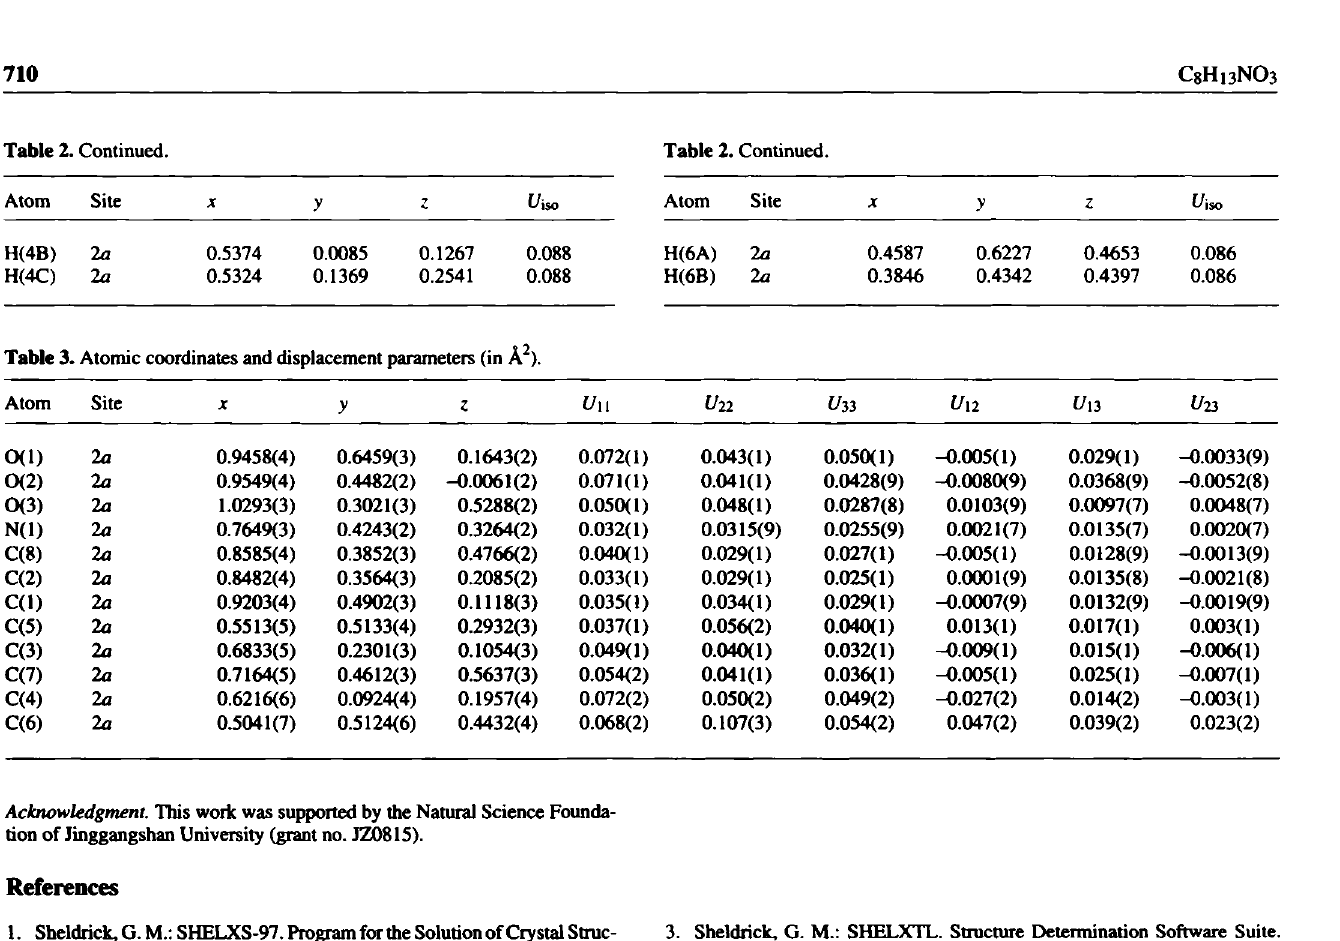
Table 3. Atomic coordinates and displacement parameters (in À 2